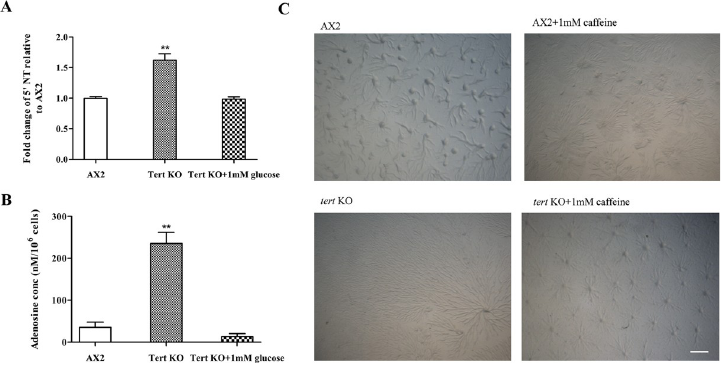
Fig 13. Effect of adenosine on aggregate size. ( A) qRT-PCR of 5’NT. Fold change in mRNA expression is relative to AX2 at indicated time points. rnlA is used as mRNA amplification control; (n = 3). (B) Quantification of adenosine levels. Level of significance is indicated as � p < 0.05, �� p < 0.01, ��� p < 0.001, and ���� p < 0.0001; (n = 3). (C) Cells were developed on KK 2 agar plates in the presence of 1 mM caffeine; tert KO streaming defect was rescued. Scale bar: 0.5 mm; (n =